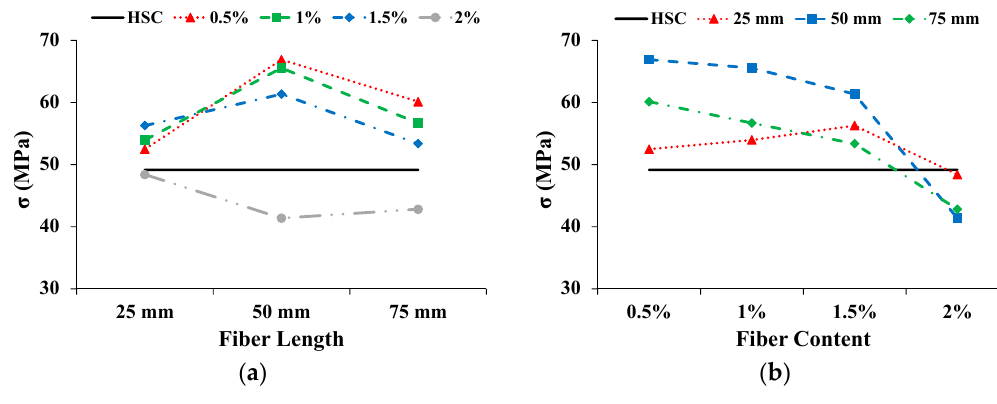
Figure 7. Influence on σ : ( a ) Fiber length; ( b ) Fiber content .